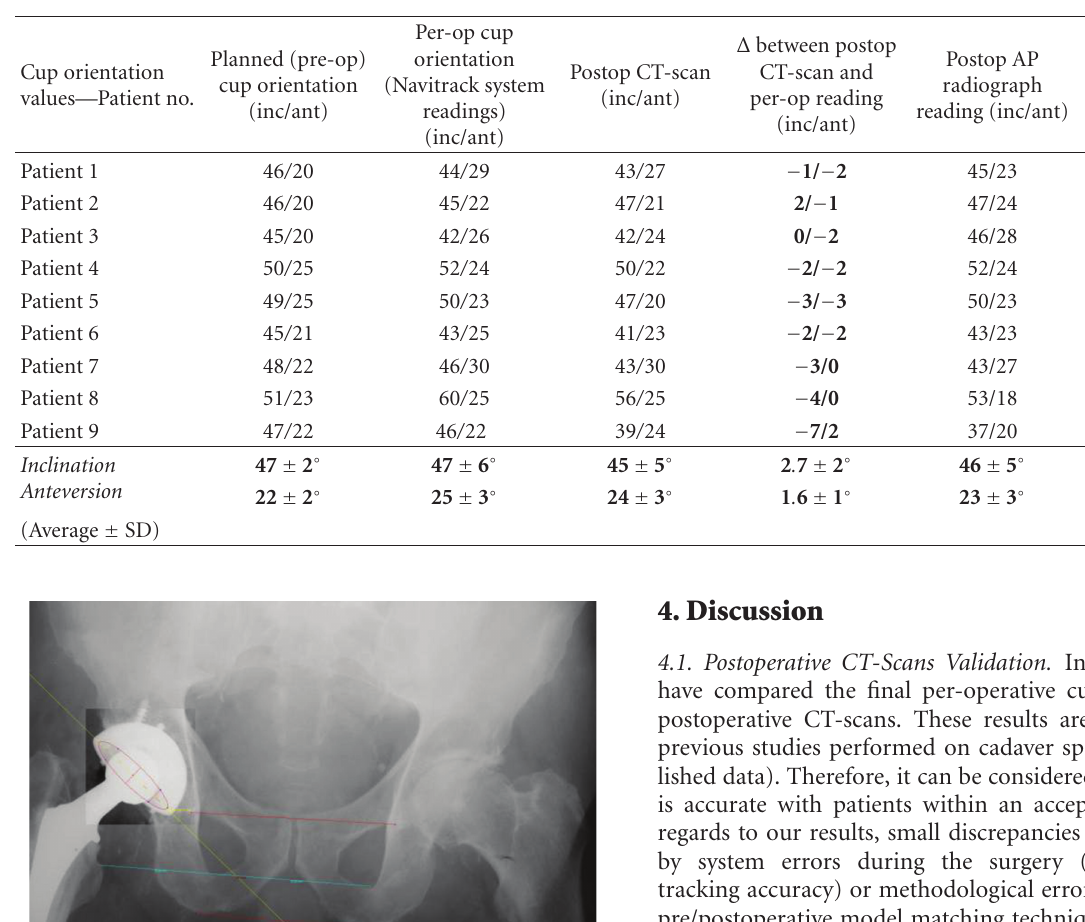
Table 1: Acetabular cup inclination (inc) and anteversion (ant) using postoperative CT-scan and AP radiograph images from 9 patients after THA.